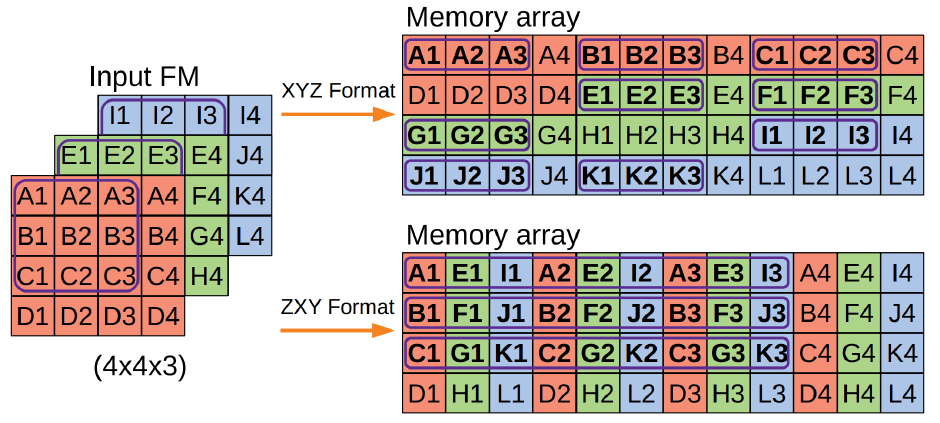
Figure 4. Data storage formats.